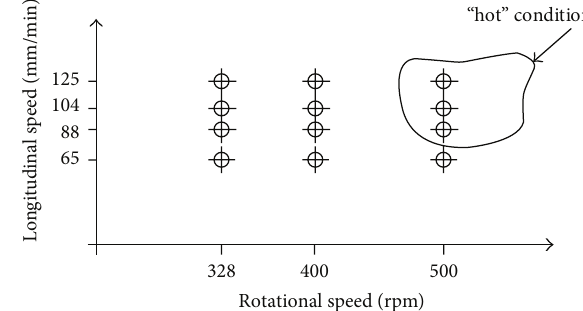
Figure 19: Processing conditions obtained with AA-5083-O.